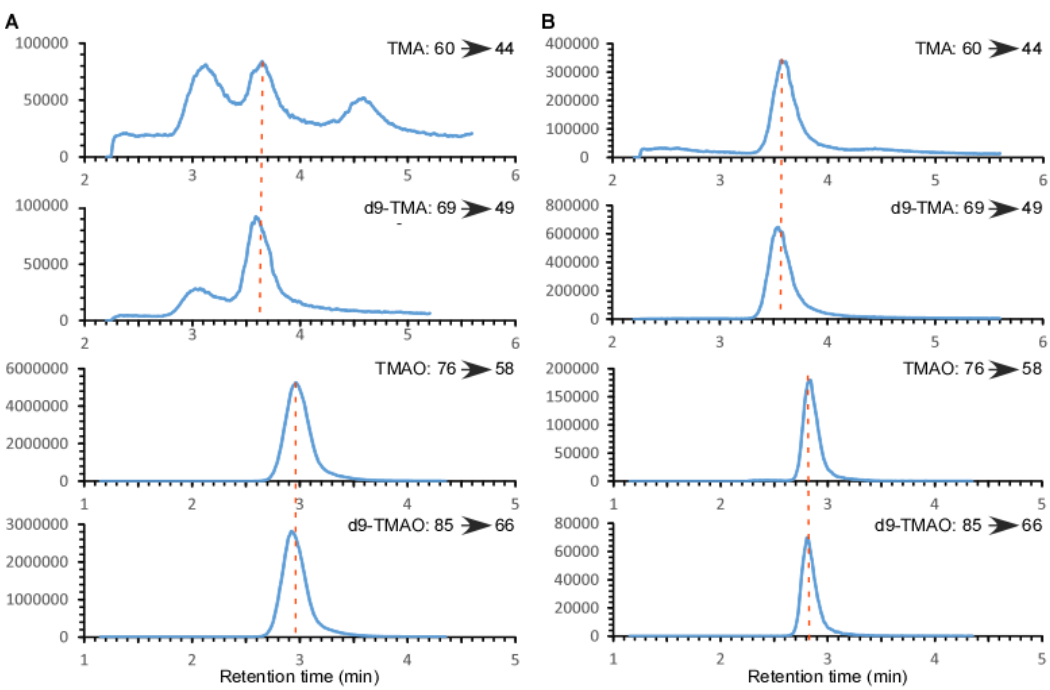
Figure 1. Extracted-ion LC chromatograms from the multiple reaction monitoring (MRM) in positive-